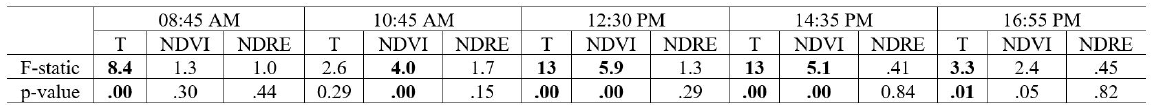
Table 2. ANOVA results of different rooting depth treatments based temporal WV3 and UAV images.